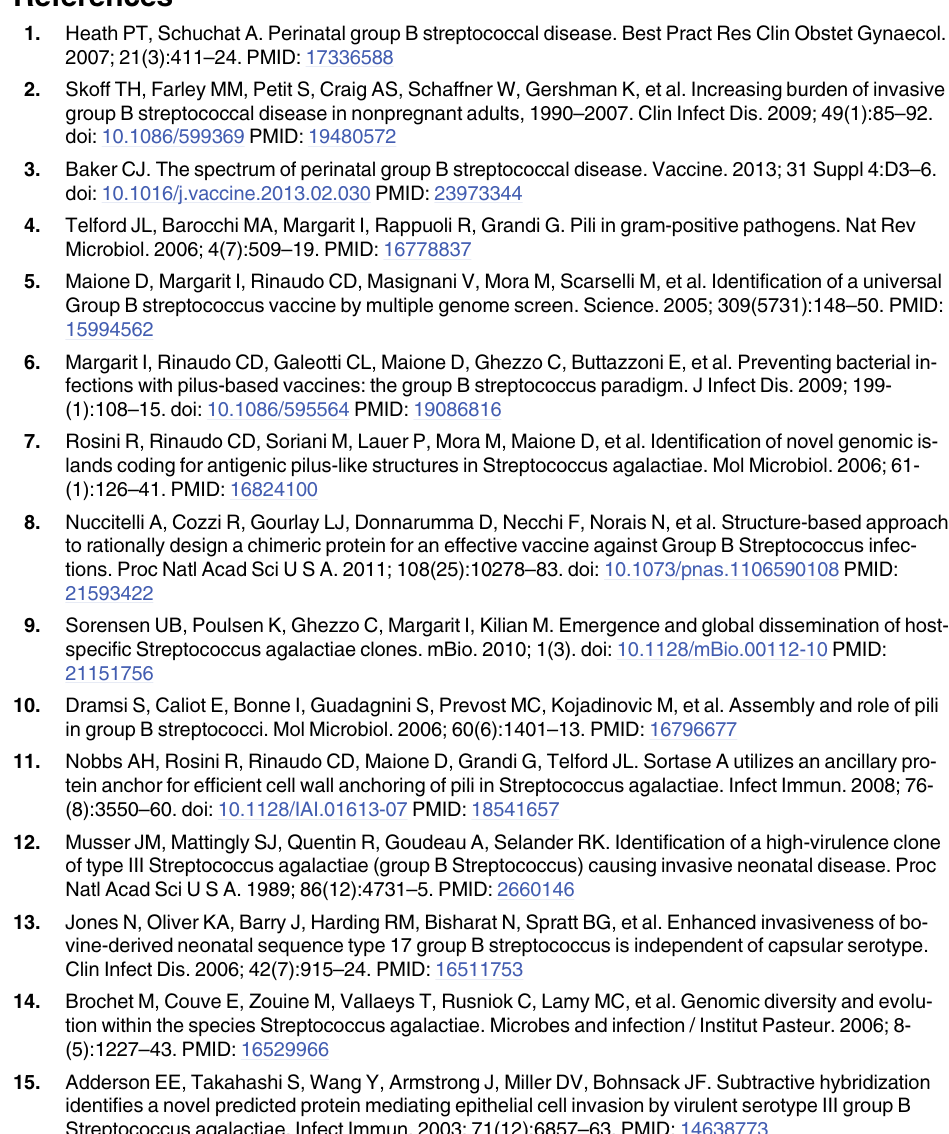
S3 Fig. Sequence comparison of BP-2a with other backbone pilins. Multiple sequence align- ment performed by using Mafft and ESPrit of BP-2b primary sequence with S . pneumoniae RrgB, GBS BP-1 and BP-2a, C . diphtheriae SpaA and SpaD, Bacillus cereus BcpA and A . nae- slundii . FimA and FimP). Identical residues are shown with a red background, whereas similar residues are shown in red and highlighted with blue